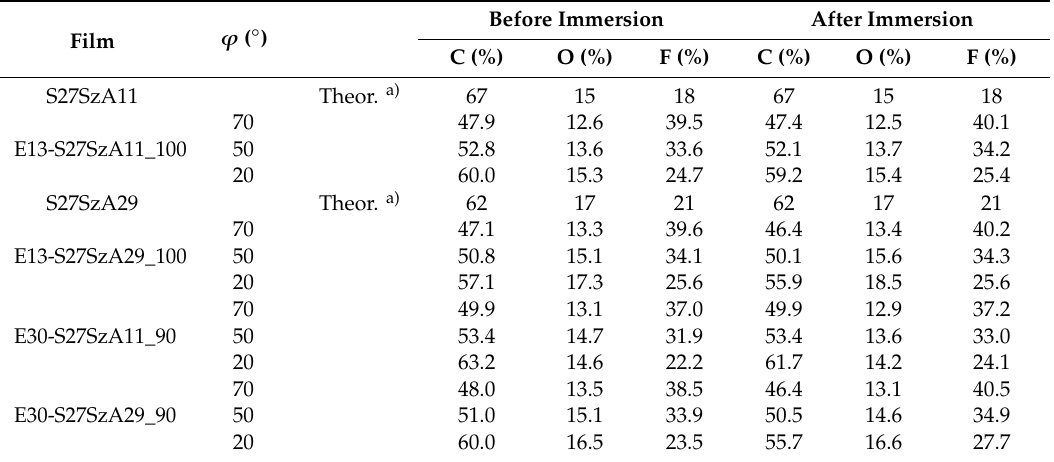
Table 5. Contact angles and surface tensions for the two-layer films and the corresponding SEBS bottom layer.